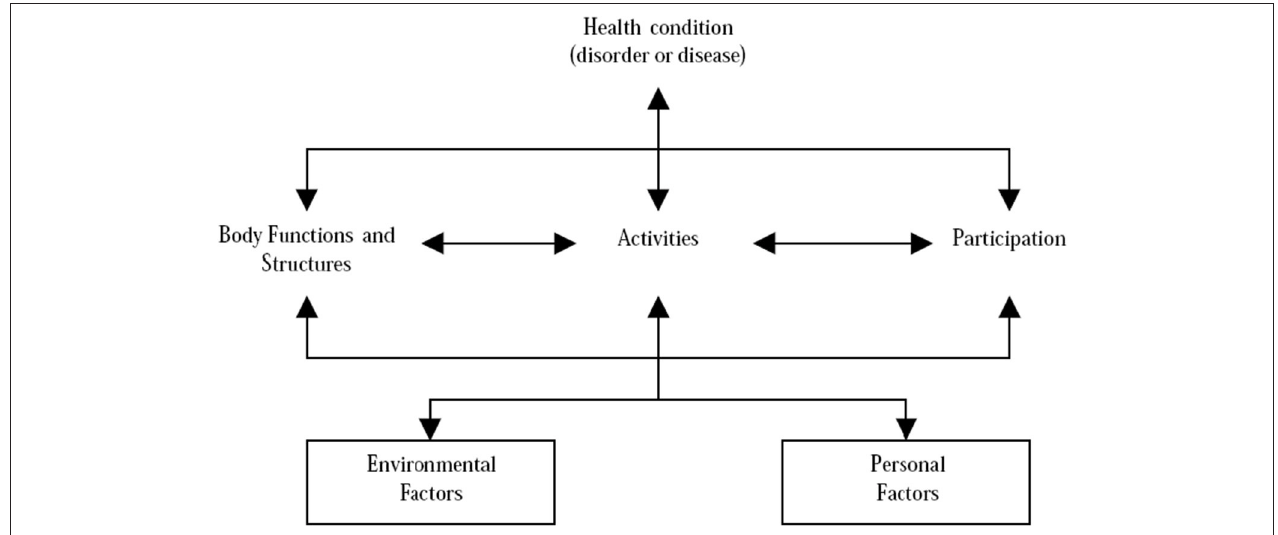
FIGURE 1 | The ICF model (World Health Organization, 2007, p. 17, figure reproduced with permission).